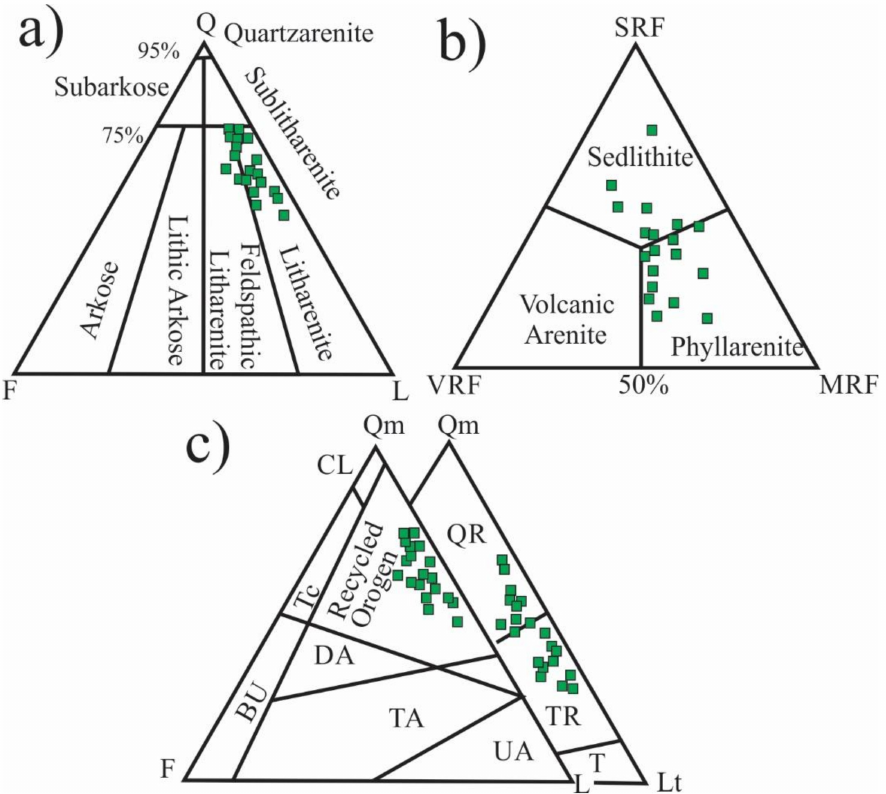
Figure 6. ( a , b ) Modal mineralogy of the Kuldana sandstones on the Aurbach, et al. [49] diagram; ( c ) displaying triangular plot values (QtFL and QmFLt) for the provenance inter- pretation of samples from the Kuldana Formation (Lr, Lithic Recycling; Ci, Craton Interior; Tr, Transitional Recycling; Tc, Transitional Continent; Qr, Quartzose Recycling; Bu, Base-Ment Uplift; Ua, Undissected Arc; Ta, Transitional Arc; Da, Dissected Arc).